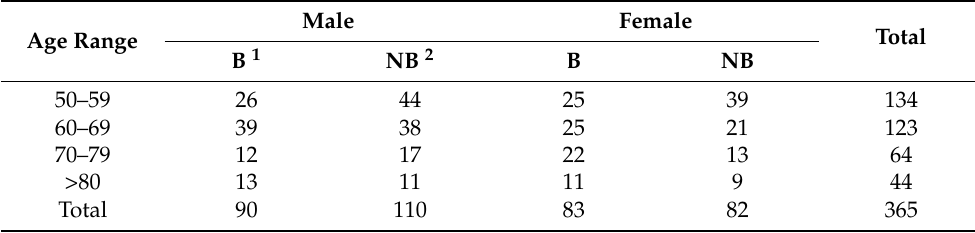
Table 1. Demographic information for study participants.